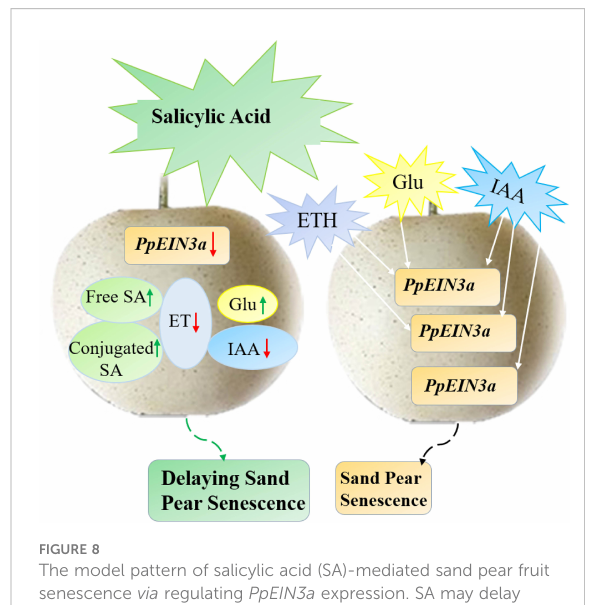
FIGURE 8 The model pattern of salicylic acid (SA)-mediated sand pear fruit senescence via regulating PpEIN3a expression. SA may delay fruit senescence by in fl uencing the contents of endogenous SA, ET, IAA, and Glu that regulating PpEIN3a expression in pulp. Green and white arrows represent up-regulation, and red arrows represent